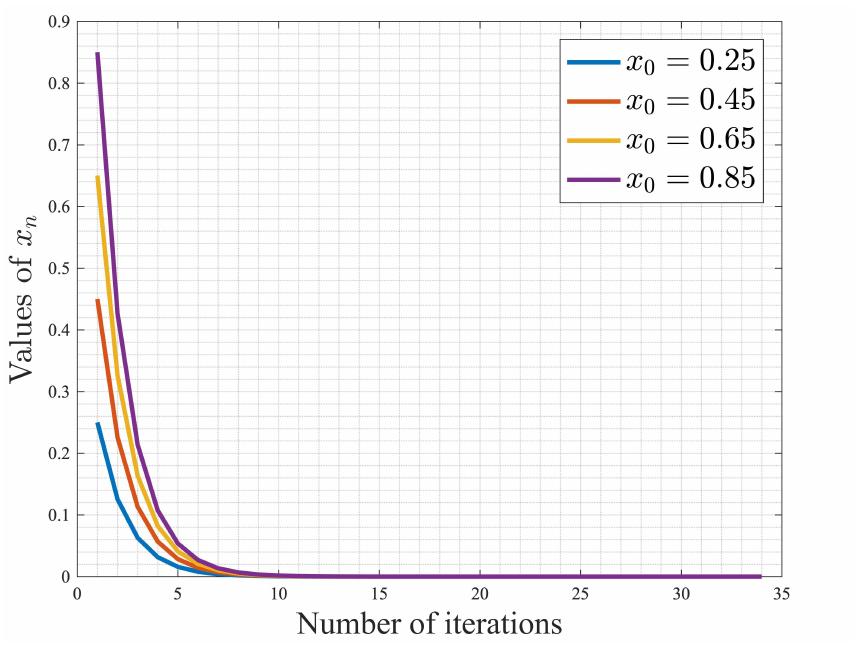
Figure 1. Values of x n